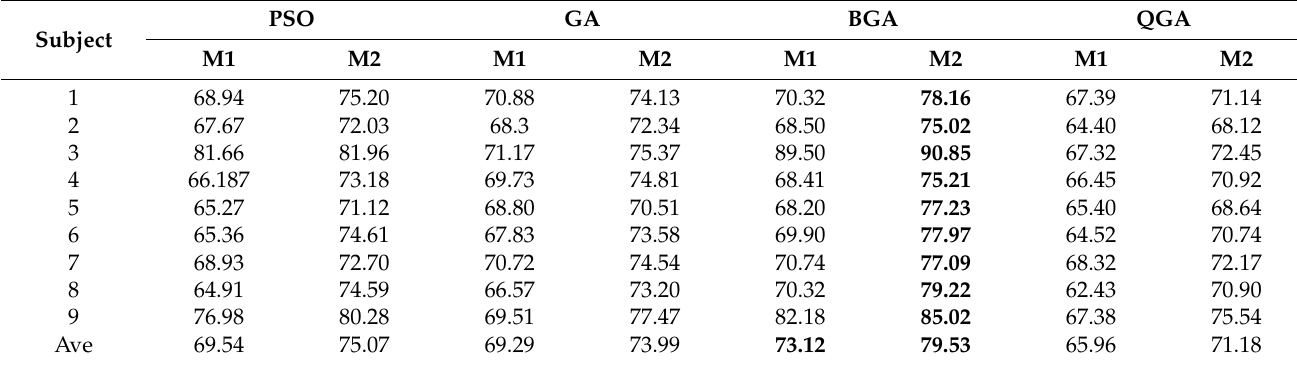
Table 15. The accuracy results of algorithms on dimension reduction and features extraction of CSP new model input matrix (using formulas) on two and three channels (C3 = 8 and CZ = 10 and C4 = 12).